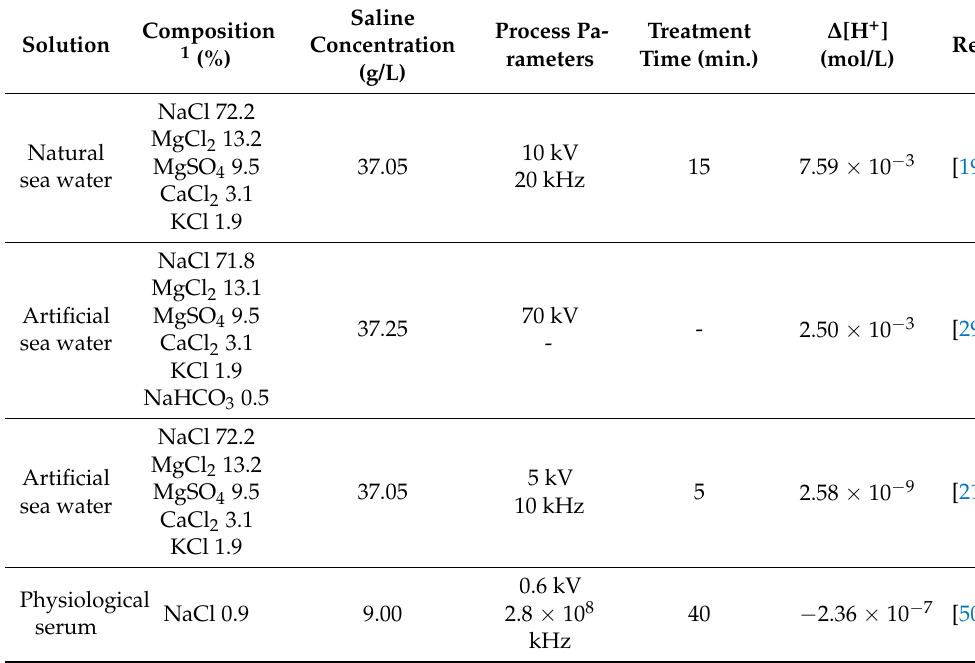
Table 2. Acidification of saline water by corona discharge.